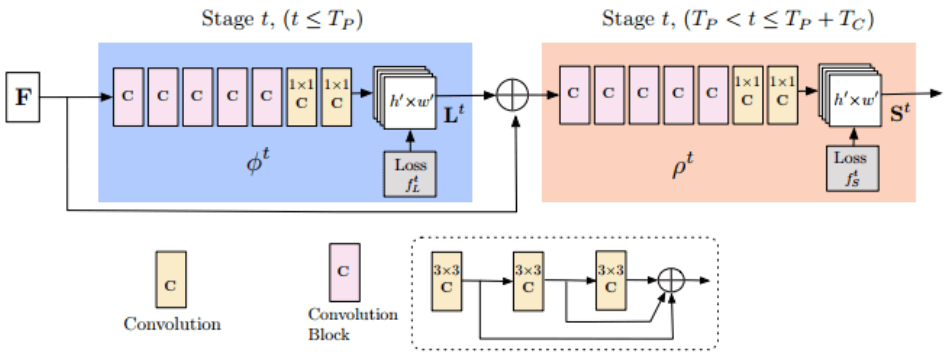
Figure 2. Architecture of the multistage CNN from the 2018 version of OpenPose [37].